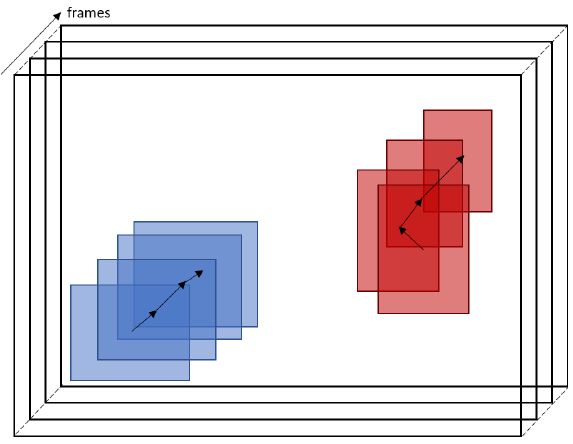
Figure 2. Example of tracking using the